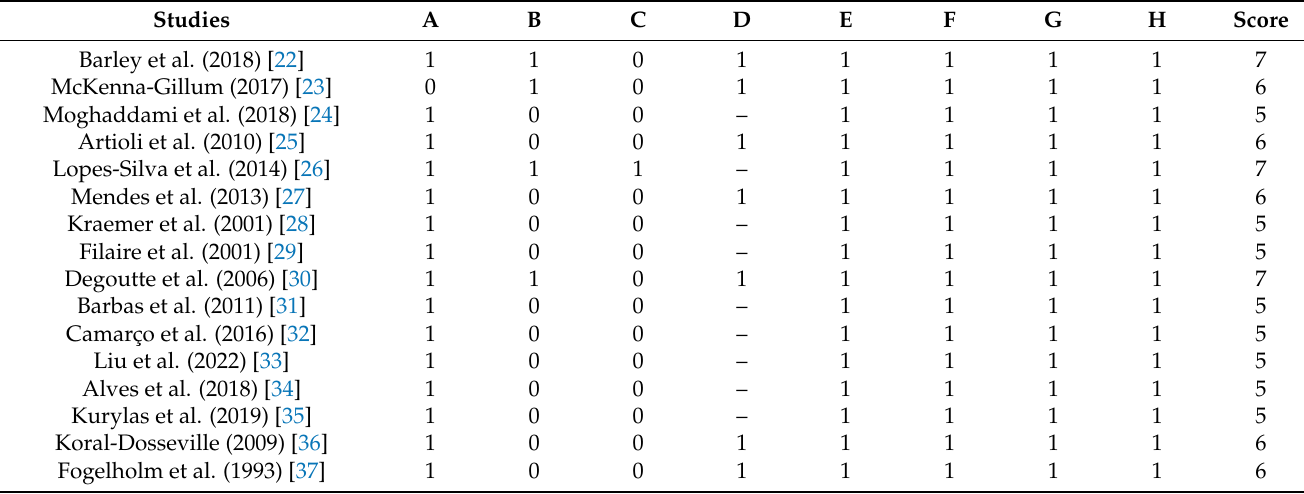
Figure 1. PRISMA fl owchart for the systematic review, describing the fi nal selection process of arti- Figure 1. PRISMA flowchart for the systematic review, describing the final selection process of articles cles included in the qualitative analysis or synthesis. included in the qualitative analysis or synthesis. Table 1. Results obtained in the evaluation of study